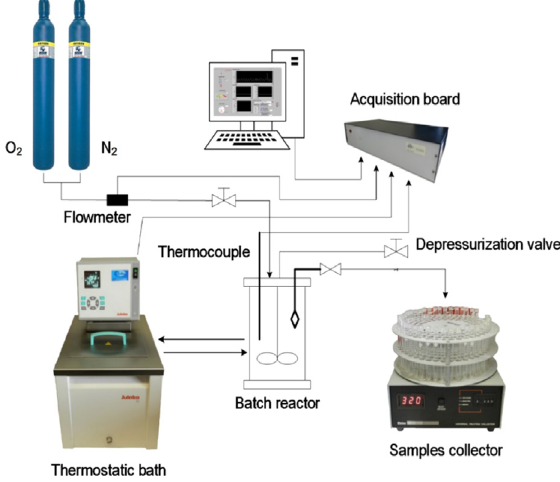
Figure 7. Experimental setup used in batch oxidation experiments at LSRE. (Reprinted with permission from [59]. Copyright 2019 American Chemical Society.)